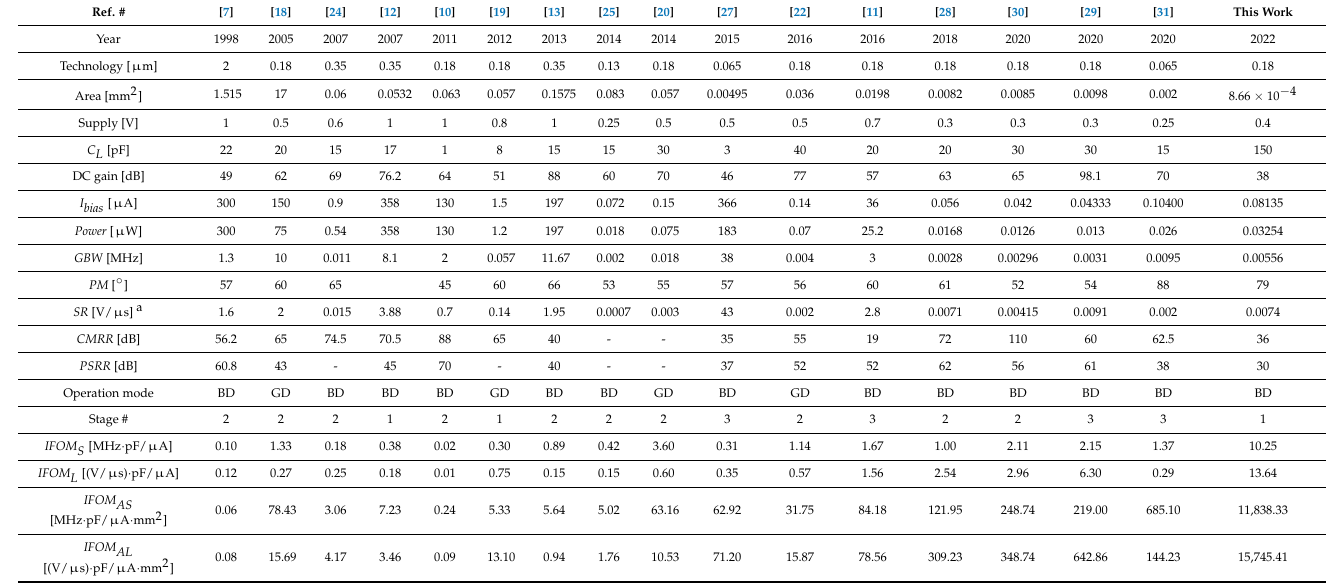
Table 6. Comparison With Other Sub-1-V